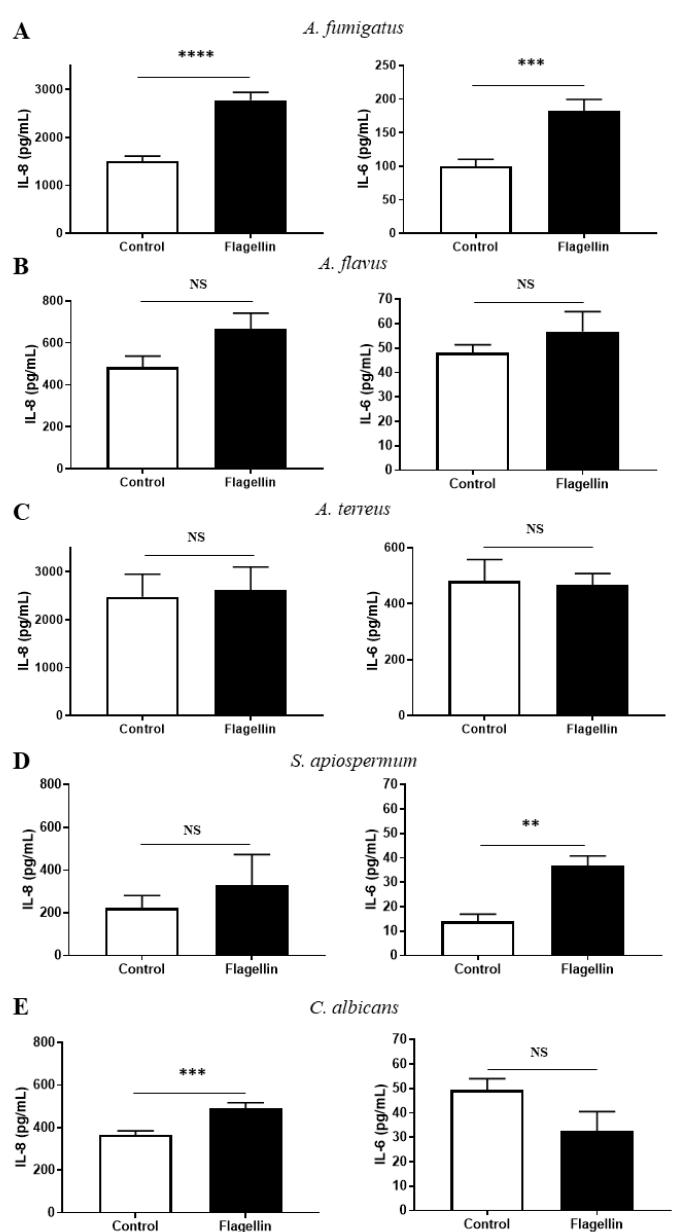
Figure 5. Inflammatory response of BEC pre-stimulated (flagellin, black bars) or not (control, white bars) with P. aeruginosa flagellin and then infected for 15 h with 4 strains of A. fumigatus ( A ), 4 strains of A. flavus ( B ), 2 strains of A. terreus ( C ), 2 strains of S. apiospermum ( D ) and 3 strains of C. albicans ( E ). IL-8 and IL-6 production are expressed as pg/mL after subtraction of the values obtained for non-infected conditions. Each histogram represents the mean ± SEM of 3 independent experiments, NS: non-significant; ** p < 0.01; *** p < 0.001; **** p < 0.0001 (Mann–Whitney